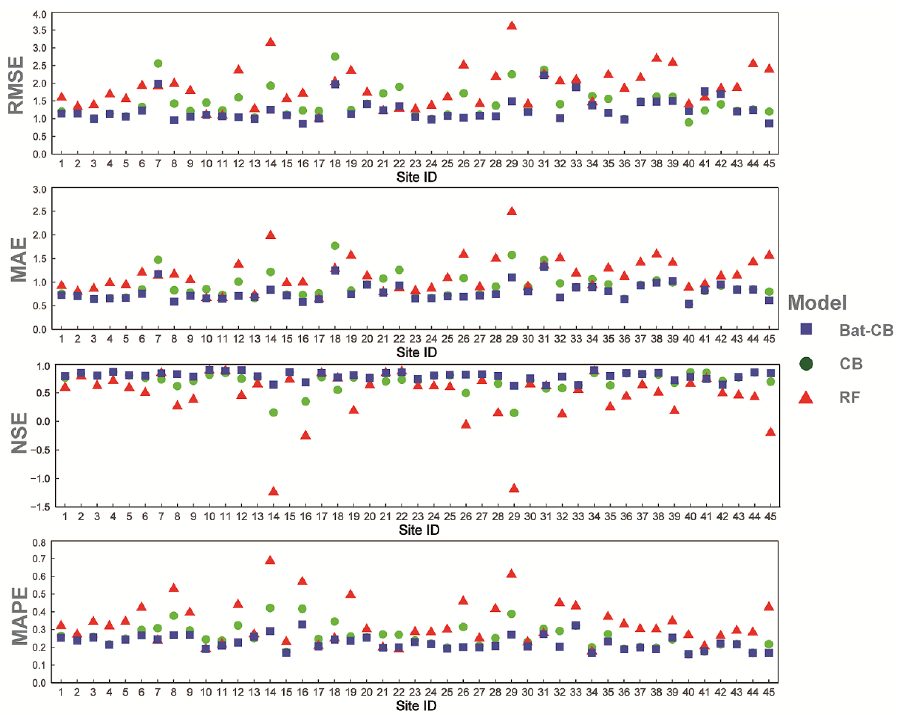
Figure 3. Scatterplots of 45 stations’ ID and values of four statistical indicators in the 45 stations generated by three models in the testing period. To further observe the performance of the models, we randomly selected six stations dispersed from the local position in the study region and drew scatter plots of measured and simulated pan evaporation values (Figure 4). It is conspicuous that the scatter plots of measured values and simulated values of the three methods during the test period are significantly different. For better exemplification, the linear fit equation and the coefficient of determination (R 2 ) were included, which provides a universal approach to measure the global adequacy of the model. The three different methods evenly have a good performance when the evaporation is small (<4mm d −1 ), but when the evaporation is large than 4mm d −1 , the RF scatter points diverted from the 1:1 liner form, and all sites showed obvious problems of overestimation or underestimation. In consideration of the special climate in the study area, the applica- bility and accuracy of RF is decreased and unconvinced in such arid and the semi-arid area where the evaporation is extremely higher than the normal levels with a long period every year. CB method was slightly better than the RF method in general, which was highly overestimated when the evaporation capacity of 52203 and 52681 stations was very large. Compared with CB, Bat-CB has a higher R 2 and convergent tendency of 1:1 line without any exception in all 6 sites as the plots showed (Figure 4.). This indicates Bat al- gorithm has a positive promotion on the CatBoost almost every site. Although the im- provement evoked from the bat algorithm seems not so conspicuous in minority stations such as the 52203 site, the bat algorithm help CB avoid the overfitting problem obviously in 51704 and 51567 sites.